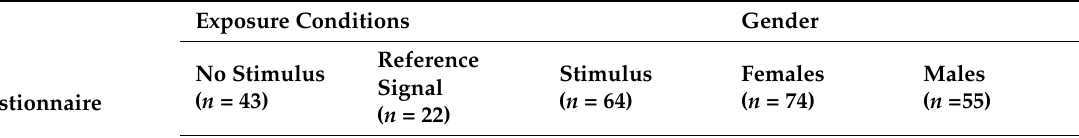
Table 2. Answers to the post-exposure questionnaire in study subjects divided into subgroups according to exposure conditions and